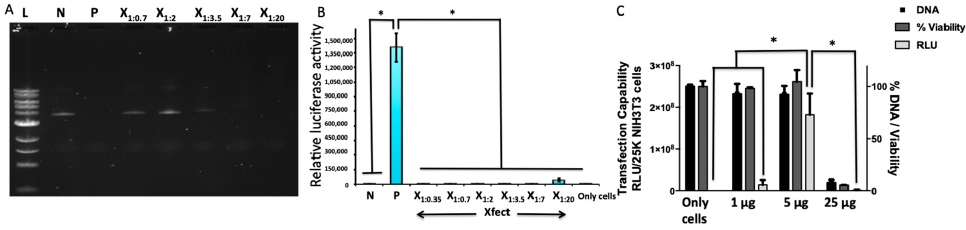
Figure 3. Optimization of transfection efficacy of GLuc polyplex complexation. ( A ) The complexation of plasmid-polymer investigated by agarose gel electrophoresis using different plasmid:polymer ratios; (Lanes 1: Ladder, 2: Naked plasmid, 3: PEI, 4: Xfect 1:0.7, 5: Xfect 1:2, 6: Xfect 1:3.5, 7: Xfect 1:7, 8: Xfect 1:20). ( B ) Analysis of transfection in NIH3T3 cells at different plasmid:polymer (plasmid/polymer) ratios by luciferase assay (Bars 1: Naked plasmid, 2: PEI, 3: Xfect